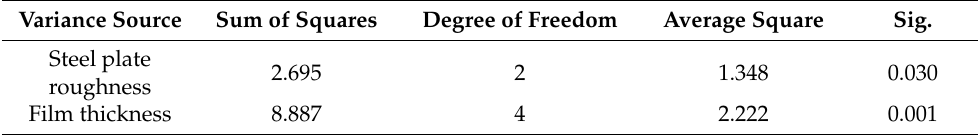
Table 15. Results of two-factor ANOVA of no-WBM bond strength.